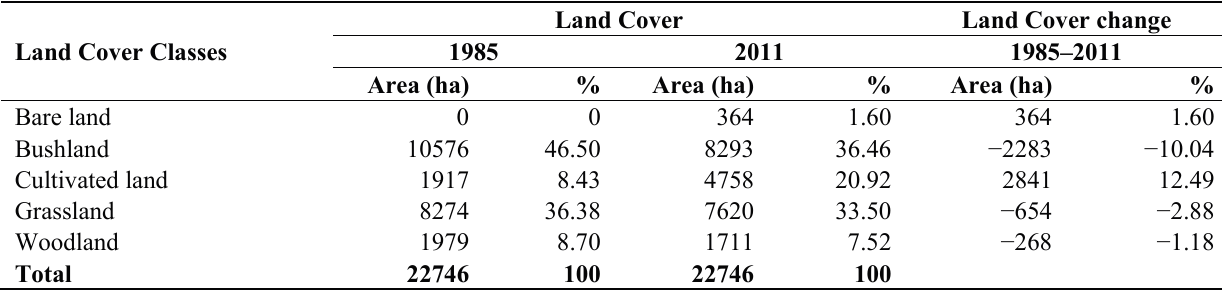
Table 2. Summary of the land cover classes and land cover changes in Darito Kebele. Land Cover Classes